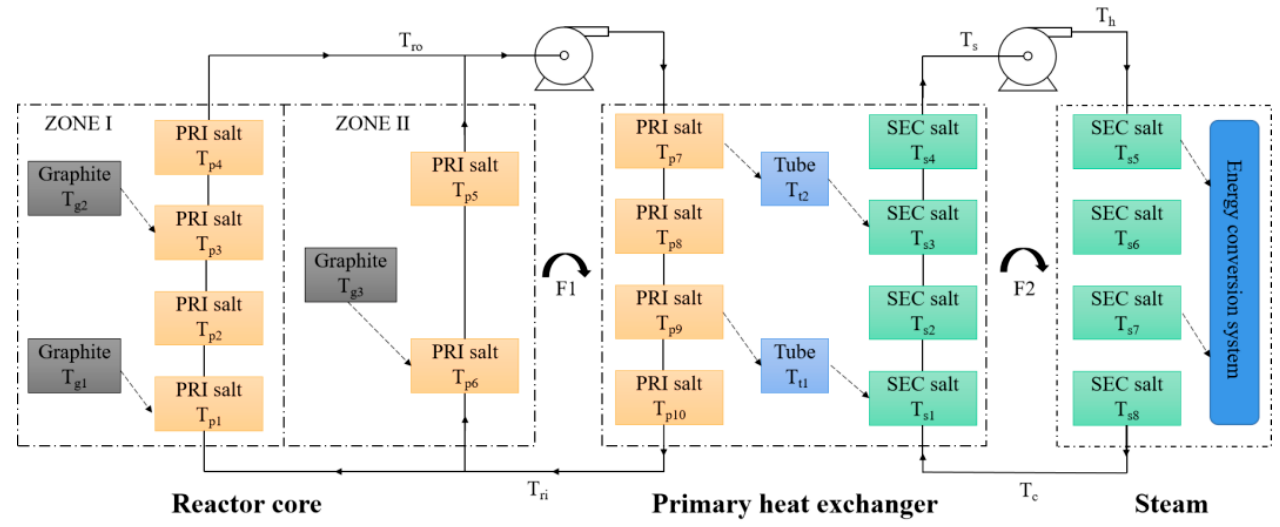
Figure 6. Lumped-parameter model for the thermal-hydraulic calculation of MSBR.